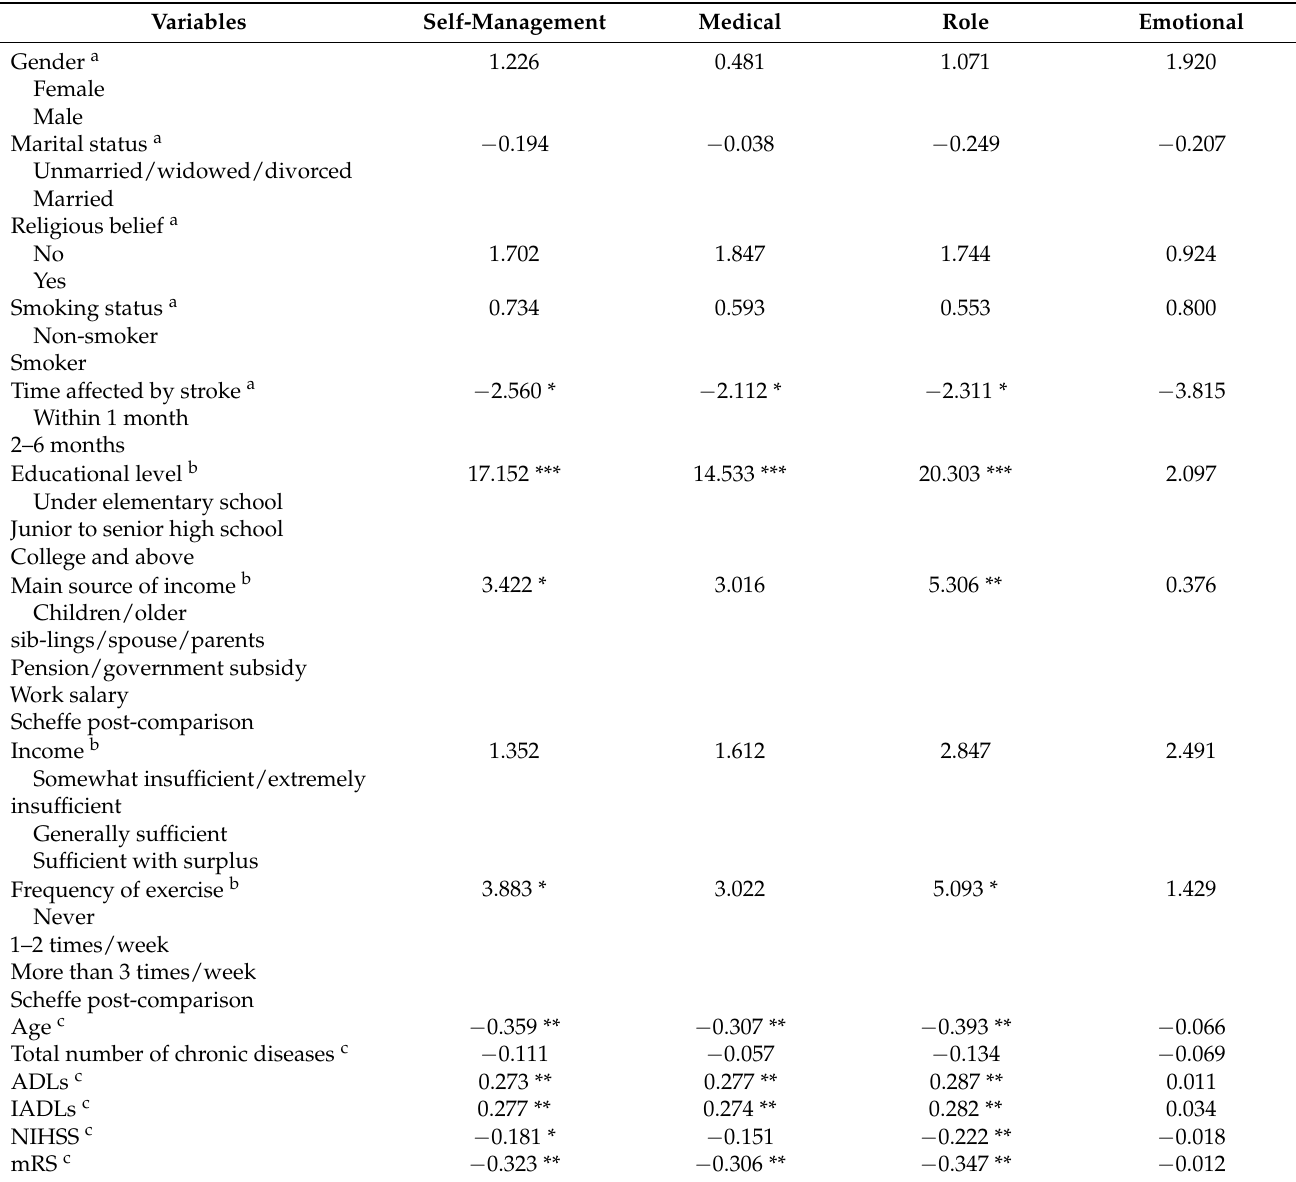
Table 3. Relationships among the basic demographic data, health status, and self-management of patients with stroke ( N =